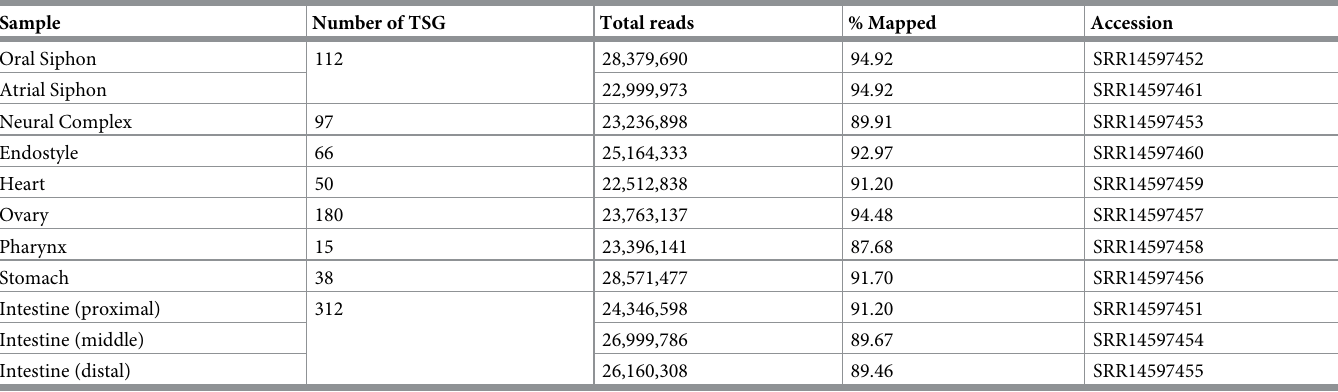
Table 1. RNA-seq summary of adult Ciona